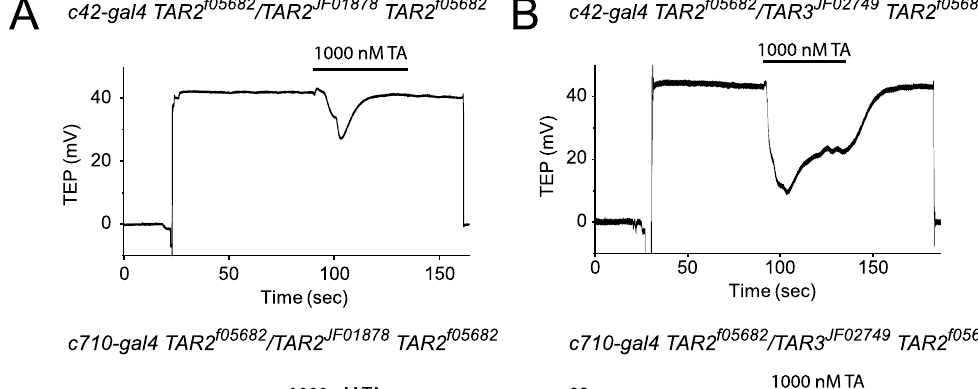
interpretations of these data. First, it is possible that the TAR2 receptor solely mediates the TA response, and that the small TA responses in mutants or after RNAi results from residual expression of TAR2 . This interpretation is consistent with our detection of very low levels of properly spliced TAR2 transcript in TAR2 f05682 homozygotes. The second interpretation is that both TAR2 and TAR3 contribute to the TA response, and that the residual TA response seen in TAR2 mutants or after TAR2 RNAi is mediated by TAR3. We believe that the results of our final experiment, in which RNAi against TAR3 but not TAR2 eliminates the residual TA response in TAR2 f05682 homozygotes, are consistent only with the second interpretation. For this final result to fit with a single functional TA receptor, one would have to argue that the TAR3 RNAi transgene was more effective at reducing TAR2 expres- sion than the TAR2 RNAi transgene. Such off-target effects are theoretically possible. However, a strong off-target effect of the TAR3 RNAi transgene is not consistent with our observation that only TAR2 RNAi, and not TAR3 RNAi, reduces the TA responses in otherwise wild-type tubules. Thus, we conclude that both TAR2 and TAR3 contribute to the depolarizing response of TA in the Malpighian tubule. As the TA response has been shown to be associated with an increase in intracellular calcium concentrations 54 , our data are consistent with the finding